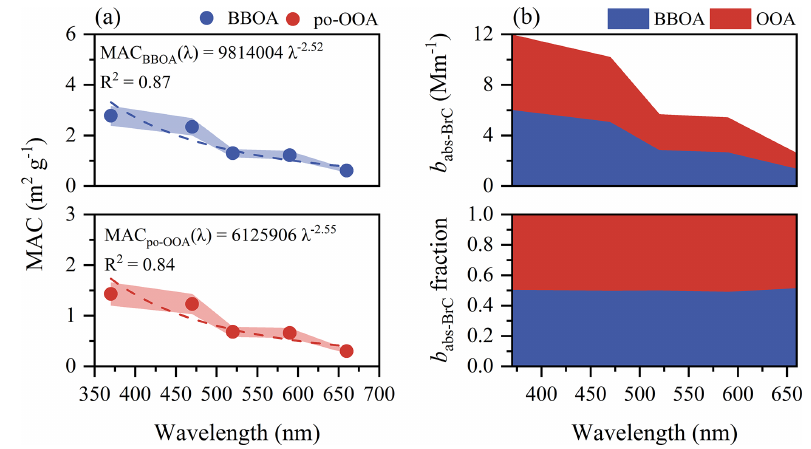
Figure 5. (a) The mass absorption cross section of BBOA and po-OOA (MAC BBOA and MAC po-OOA , respectively) at five wavelengths ( λ = 370, 470, 520, 590, and 660nm). The circle and shaded area represent the mean MAC values and the standard deviations, respectively. The dashed line is the power-law fit. (b) The light absorption coefficient of BrC ( b abs-BrC ) from BBOA and po-OOA and its fraction in the total reconstructed BrC absorption at different